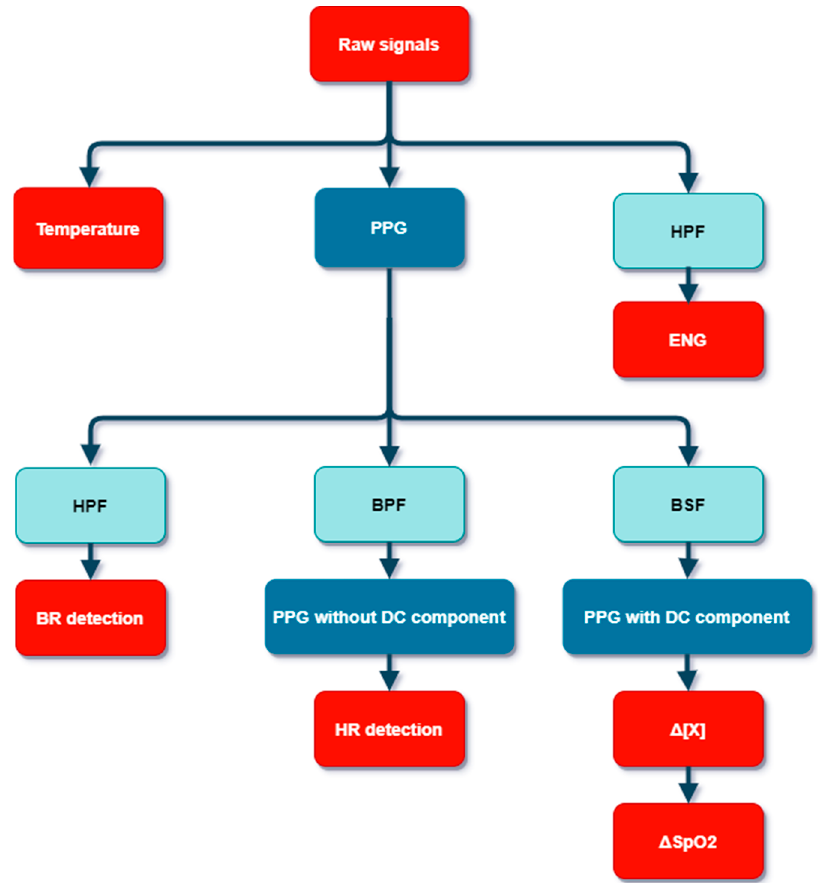
Figure 7. Flowchart of the signal processing (PPG: PhotoPlethysmoGrams; HPF: High-Pass Filter; ENG: ElectroNeuroGraphy; BPF: Band-Pass Filter; BSF: Band Stop Filter; BR: Breath Rate; HR: Heart Rate; DC: Direct Current).